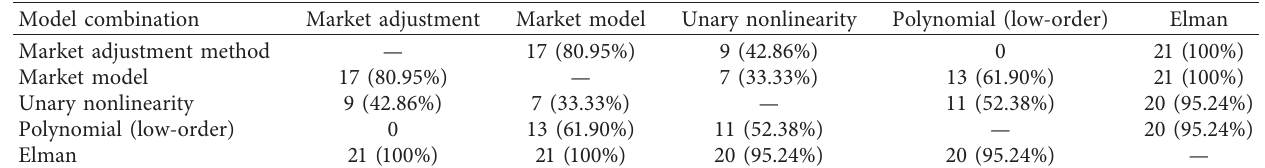
Table 5: The days with significant difference in the window period between 5